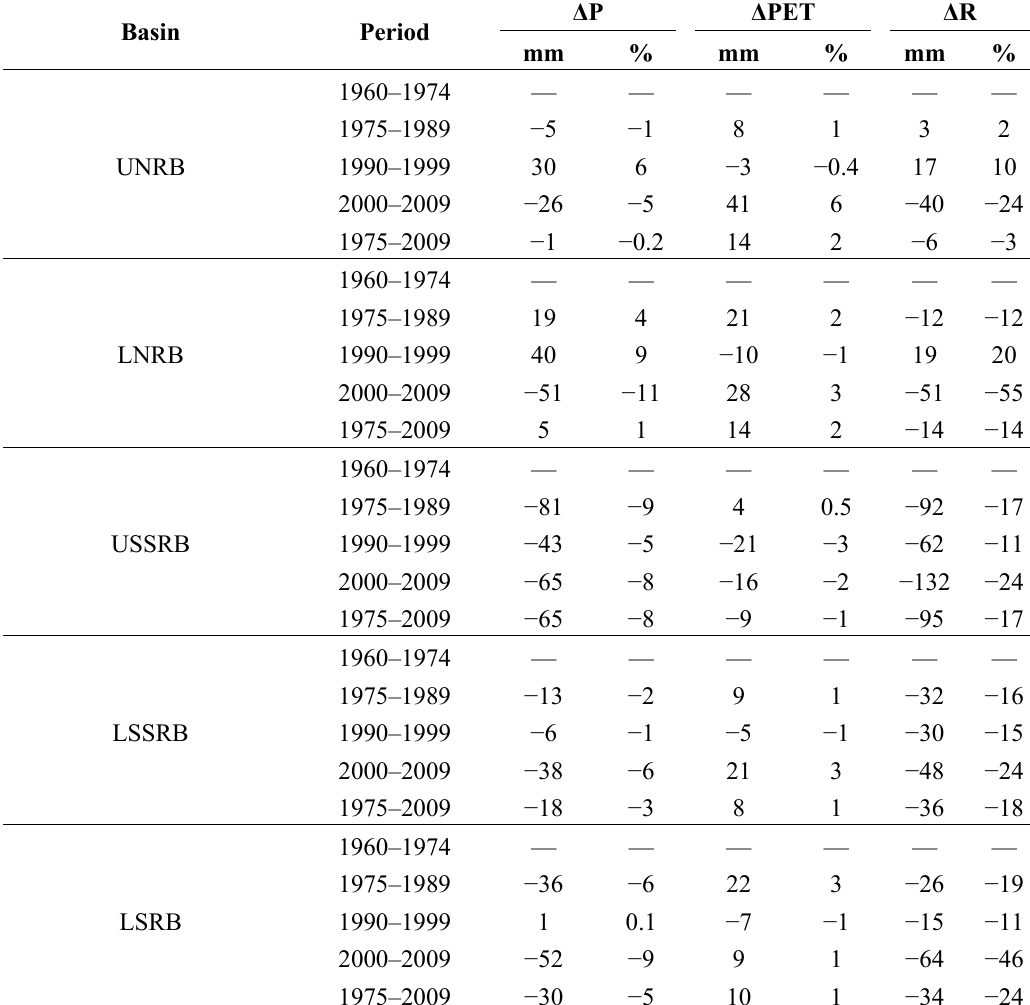
Table 4. Changes in precipitation, PET, and runoff during different periods in the Upper Nenjiang River Basin (UNRB), Lower Nenjiang River Basin (LNRB), Upper Second Songhua River Basin (USSRB), Lower Second Songhua River Basin (LSSRB), and Lower Songhua River Basin (LSRB) in Northeast